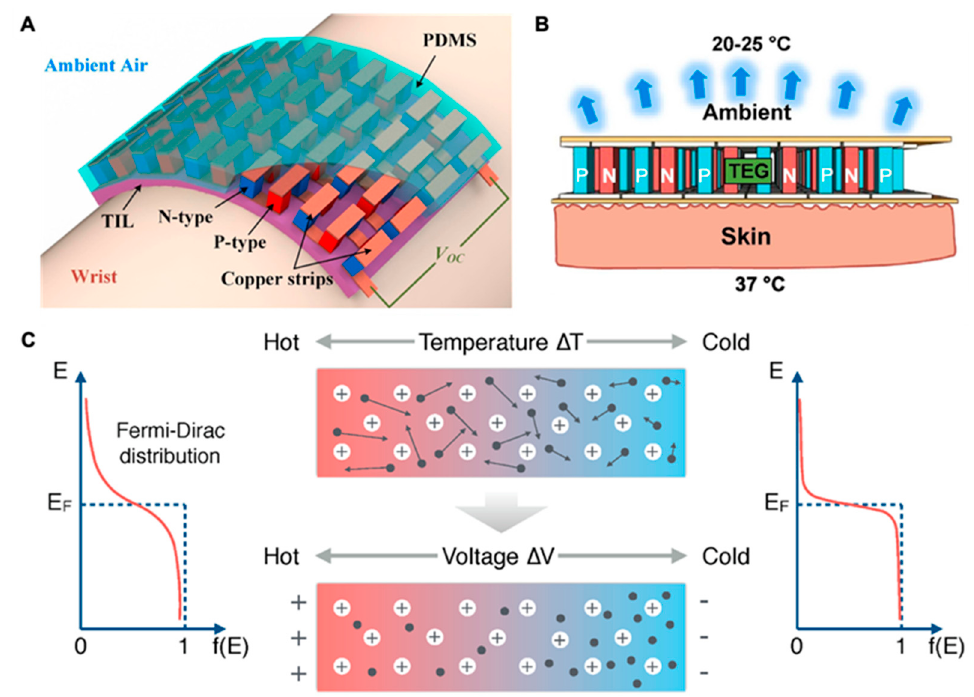
Figure 3. ( A ) A schematic of WTEG on a human wrist, reprinted from [45], copyright (2017), Wang, Y.; Shi, Y.; Mei, D.; Chen, Z, with permission from Elsevier; ( B ) the cross-sectional view of the thermoelectric process in WTEG on human skin, reprinted from [2], copyright(2019), Nozariasbmarz, A.; Collins, H.; Dsouza, K.; Polash, M.H.; Hosseini, M.; Hyland, M.; Liu, J.; Malhotra, A.; Ortiz, F.M.; Mohaddes, F, with permission from Elsevier; ( C ) the Seebeck effect in the WTEG, reprinted from [41], copyright (2020), Park, J.; Bhat, G.; Nk, A.; Geyik, C.S.; Ogras, U.Y.; Lee, H.G, with permission from MDPI.